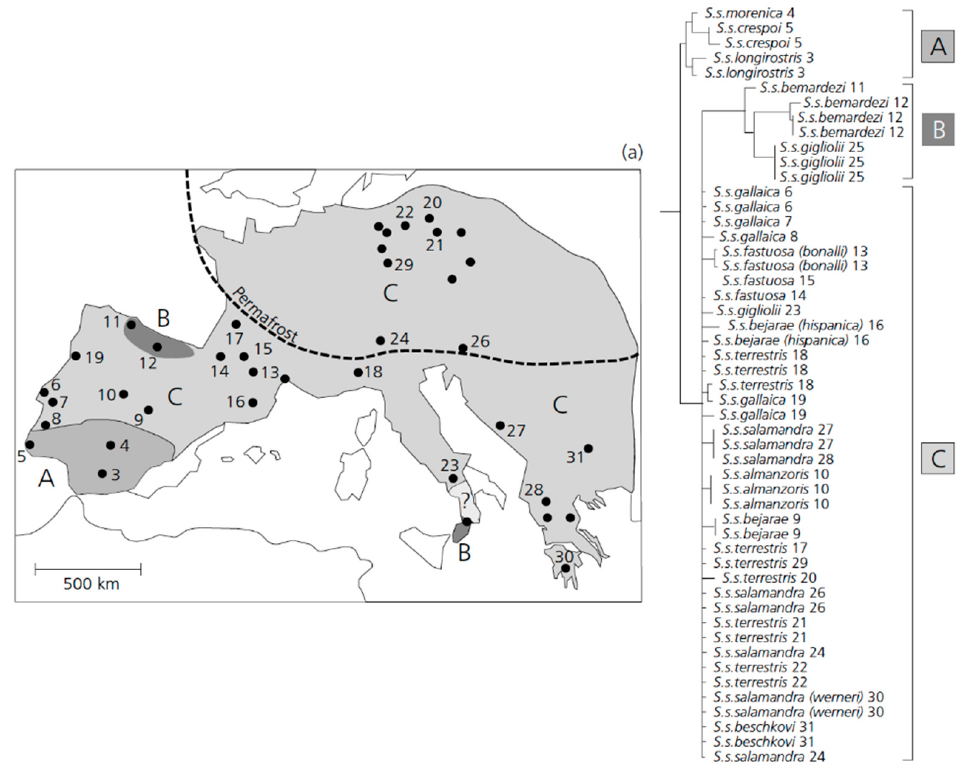
Figure 2. The geographic distribution of different clades within Salamandra salamandra across Europe derived from a population-based phylogeny of the mitochondrial D-loop [322]. The different shades of grey—the distribution of different phylogenetic clades. The distribution range of the subspecies S. s. gigliolii is uncertain (question mark). The dashed line—the approximate line of permafrost during the height of the last glaciation. Note that clade B shows an interrupted pattern by populations of clade C. (Modified after [322]).